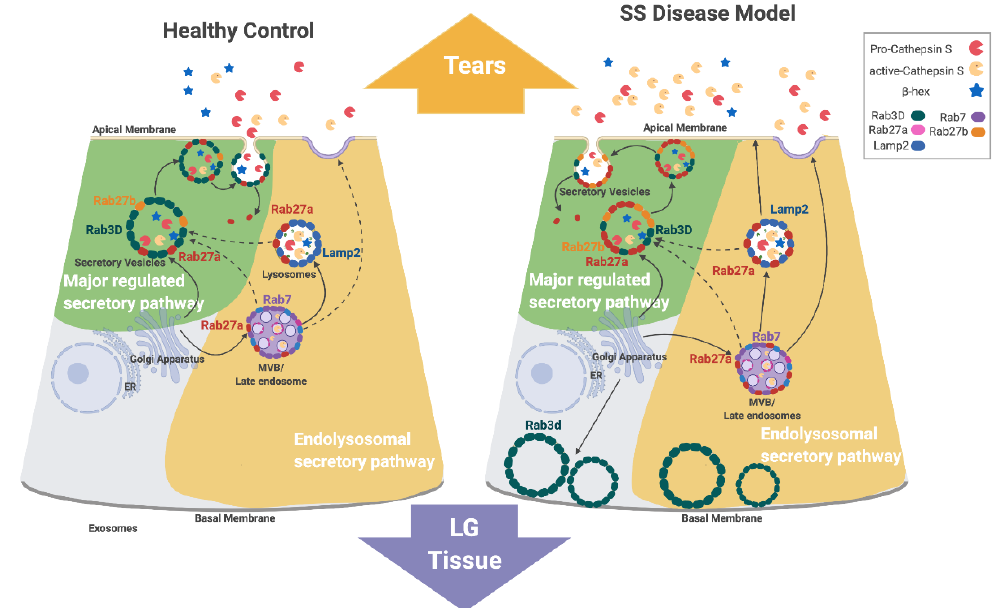
Figure 8. Proposed mechanism of Rab27a involvement in CTSS traffic in LGAC. CTSS is synthesized and initially sorted to endolysosomal compartments. Rab27a regulates CTSS secretion at the APM though both the major regulated secretory pathway and a direct endolysosomal secretory pathway. In healthy LGAC, Rab27a-enriched endolysosomally-derived vesicles may fuse with Rab3D-enriched SV, generating SV enriched in Rab3D, Rab27a and Rab27b containing small amounts of CTSS and other lysosomal enzymes that are secreted with stimulation. In SS, the depletion of Rab3D-enriched SV leads to accumulation of Rab27a-enriched endolysosomally derived vesicles that may accumulate and fuse directly with the APM to release increased CTSS, in the absence of a functional major regulated secretory pathway. Solid lines highlight mechanisms supported as the most likely in the study while dashed arrows represent alternative mechanisms. Figure created with BioRender.com 2020 version (Toronto, ON, Canada).